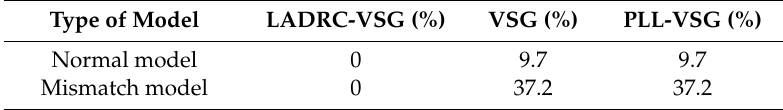
(1.16–2 s, one decimal place e